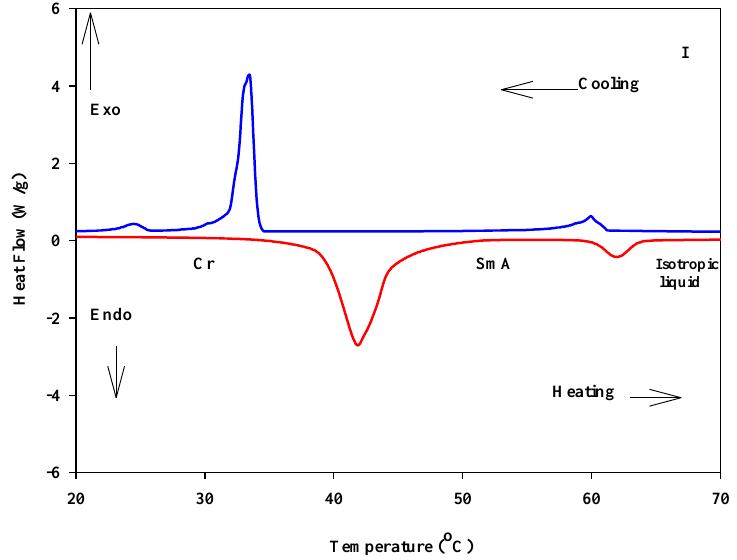
Figure 2. Differential scanning calorimetry (DSC) thermograms upon heating/cooling cycles of Figure 2. Di ff erential scanning calorimetry (DSC) thermograms upon heating / cooling cycles of compound I with heating rate 10 °C/min. compound I with heating rate 10 ◦ C /